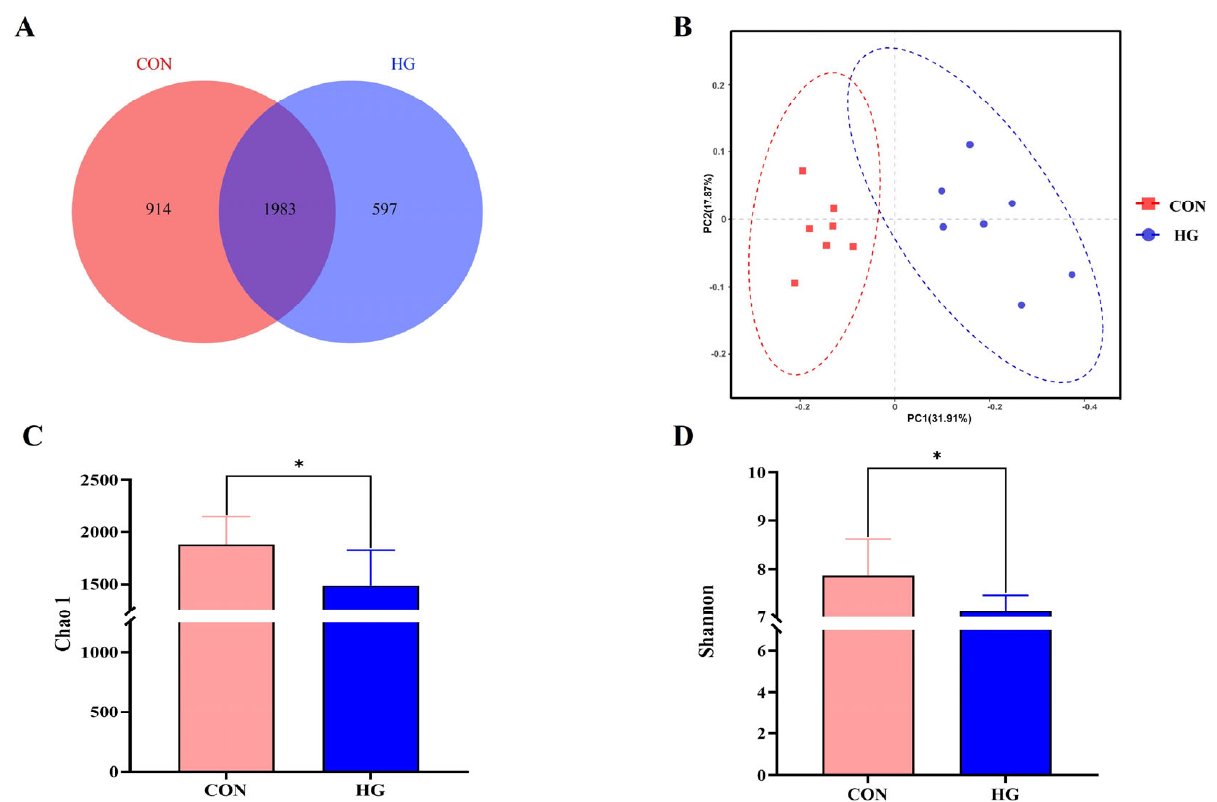
Figure 1. The operational taxonomic unit (OTU) numbers, ruminal bacterial diversity and richness, and principal coordinate analysis (PCoA) of yaks fed different diets. CON, hay group; HG, high-grain group. ( A ) Venn diagram of OTUs in the ruminal microbiota; ( B ) principal coordinate analysis (PCoA); ( C ) Chao1 index used to estimate ruminal bacterial richness; and ( D ) Shannon index used to estimate ruminal bacterial diversity. * p < 0.05.